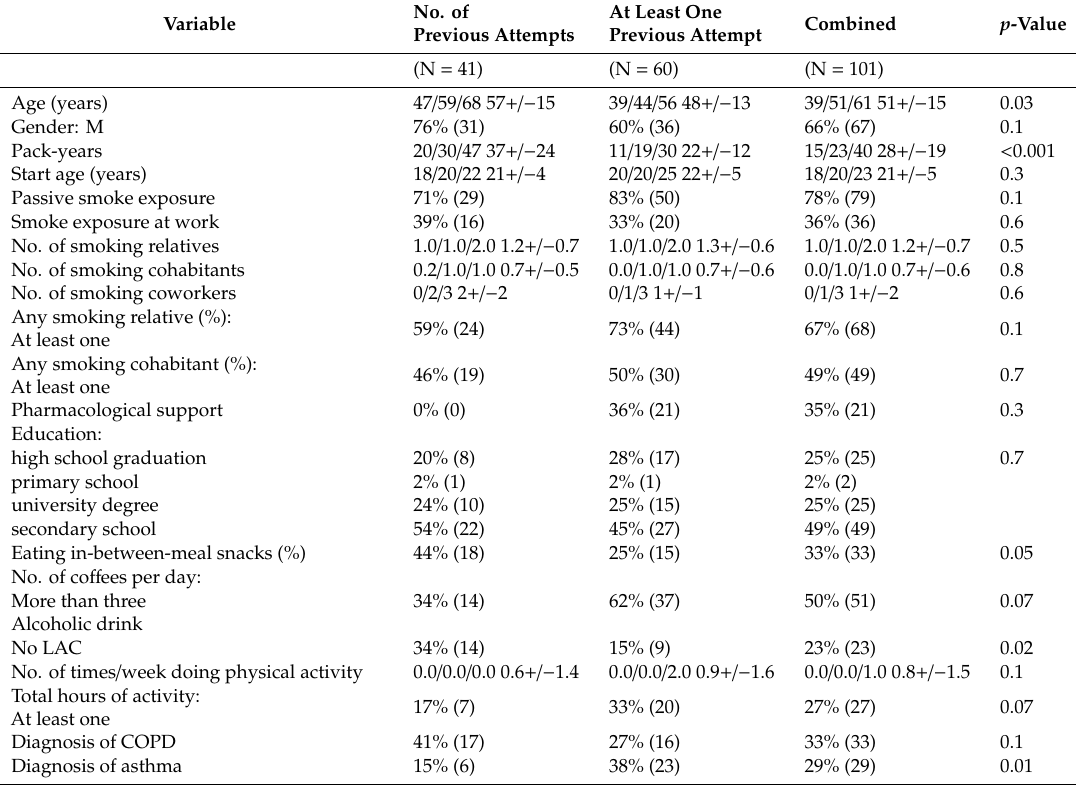
Table 2. Patients’ characteristics in the active smoker group according to previous attempts to quit smoking. Variable